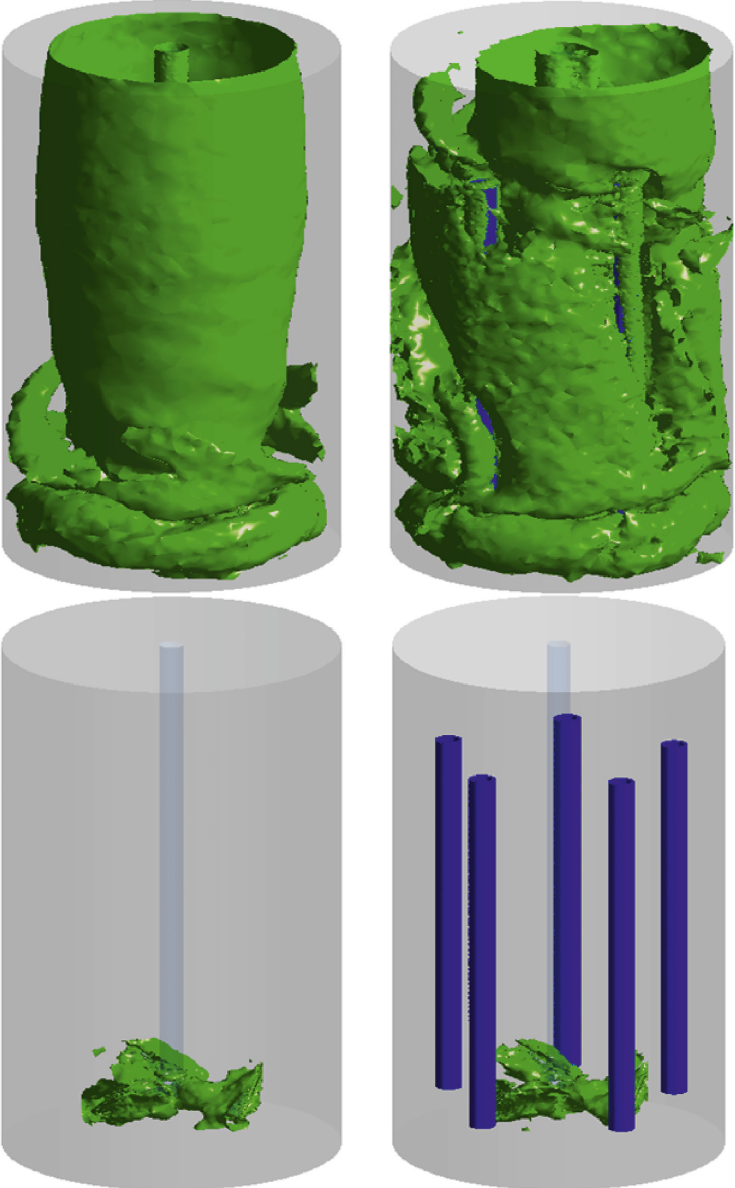
Figure 14: The overall solid holdup distribution in the tank and the solid holdup distribution near the